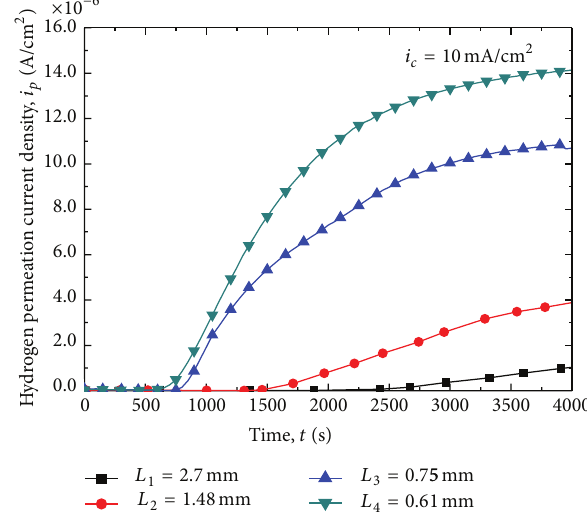
Figure 5: Hydrogen permeation curves for different thickness of the silicon steel under the same hydrogen charging current density.